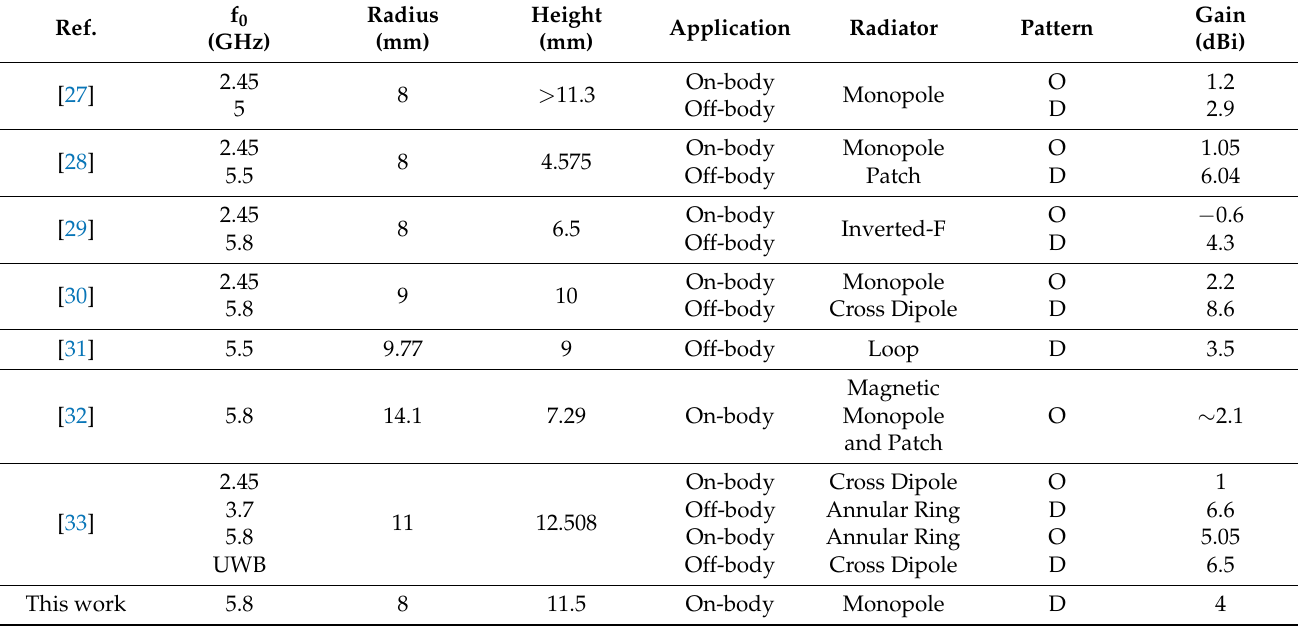
Table 3. Comparisons with other works (O: omnidirectional; D: directional). Ref.